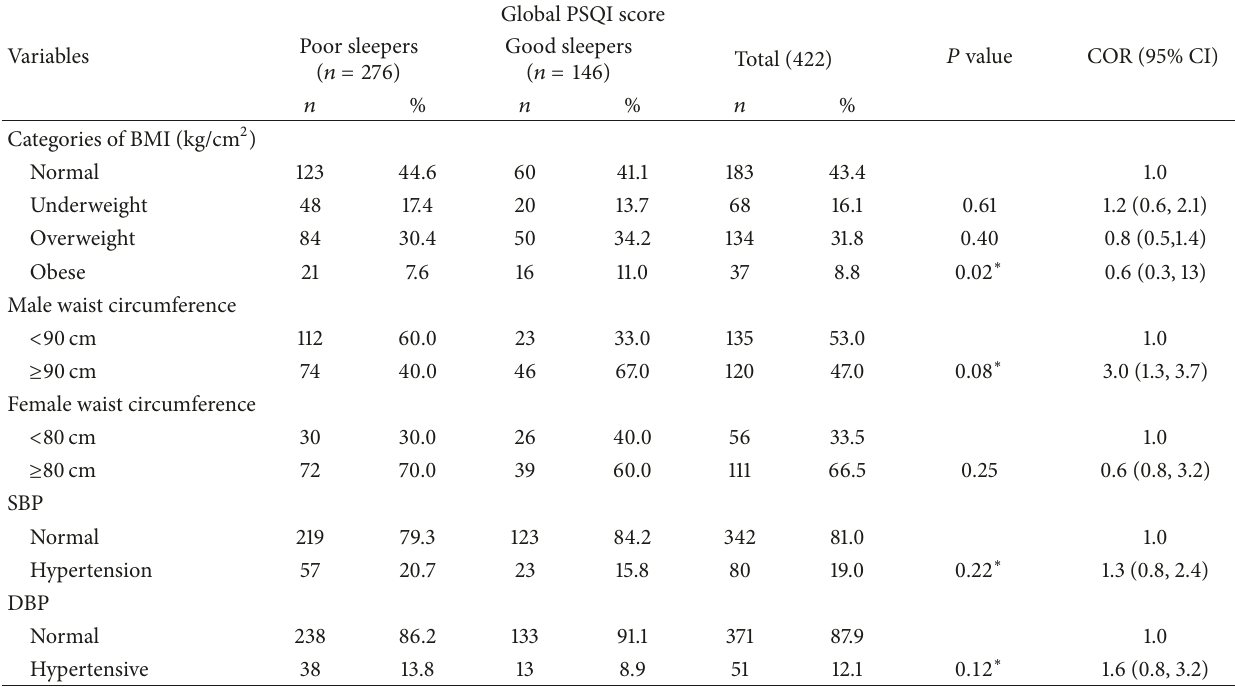
Table 5: Body composition and BP measurements and their association with sleep quality among sampled adults in Jimma town, April 2016.